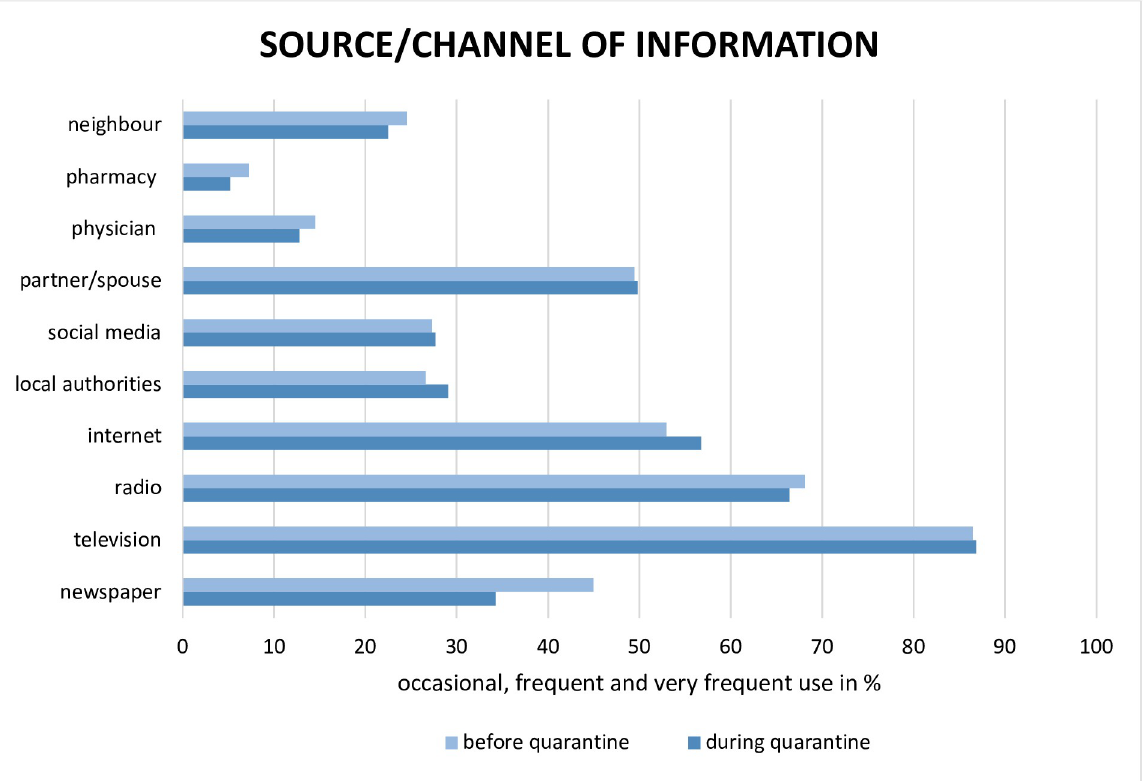
Fig 2. Use of media and sources/channels of information before and during quarantine. The graph shows the percentage of the combined results of occasional, frequent and very frequent use.